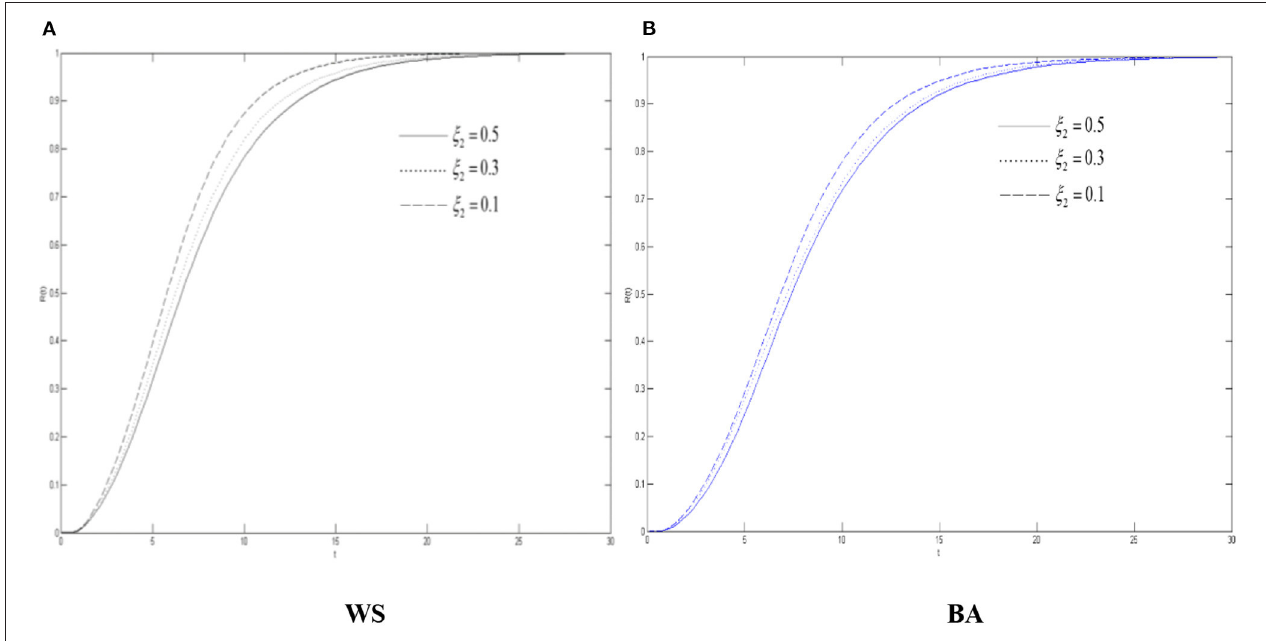
FIGURE 9 | The differences of the recovery density in WS small world and BA scale-free network when ξ 2 changes. (A) WS, (B) BA.